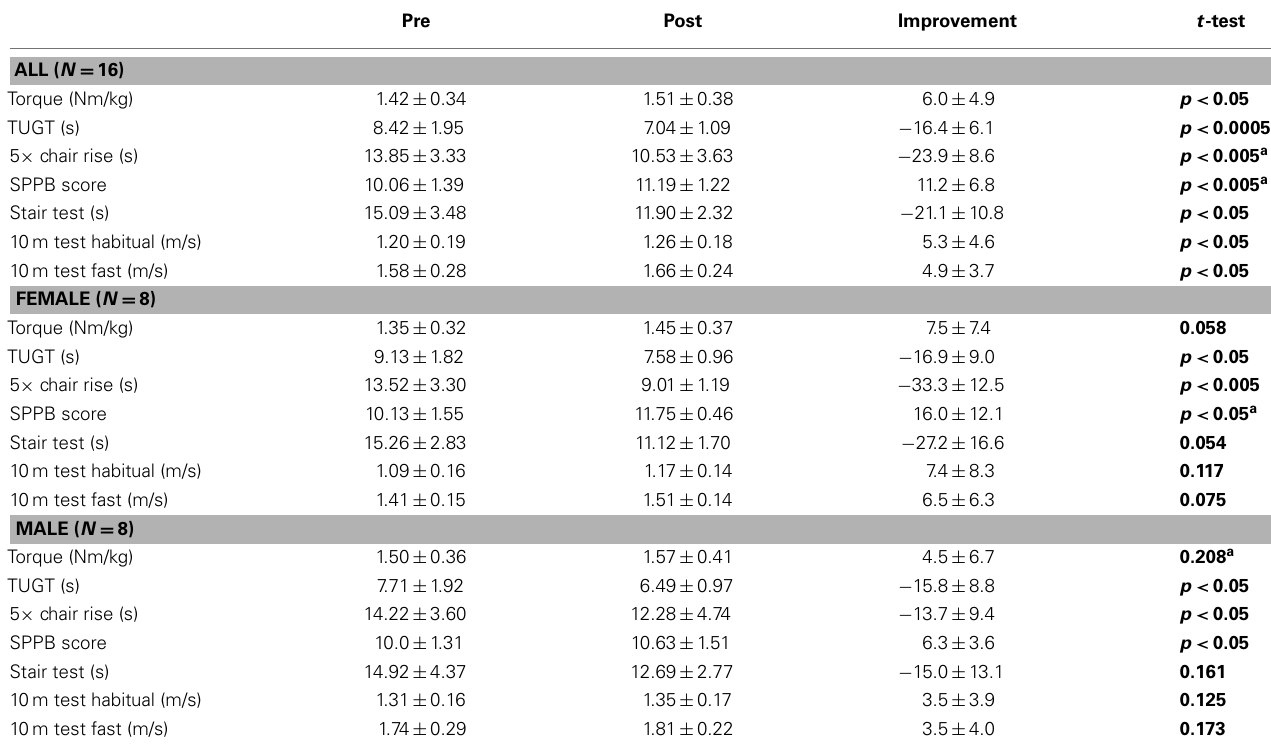
Table 1 | Force measurements and functional tests of seniors with muscle weakness before and after ES training